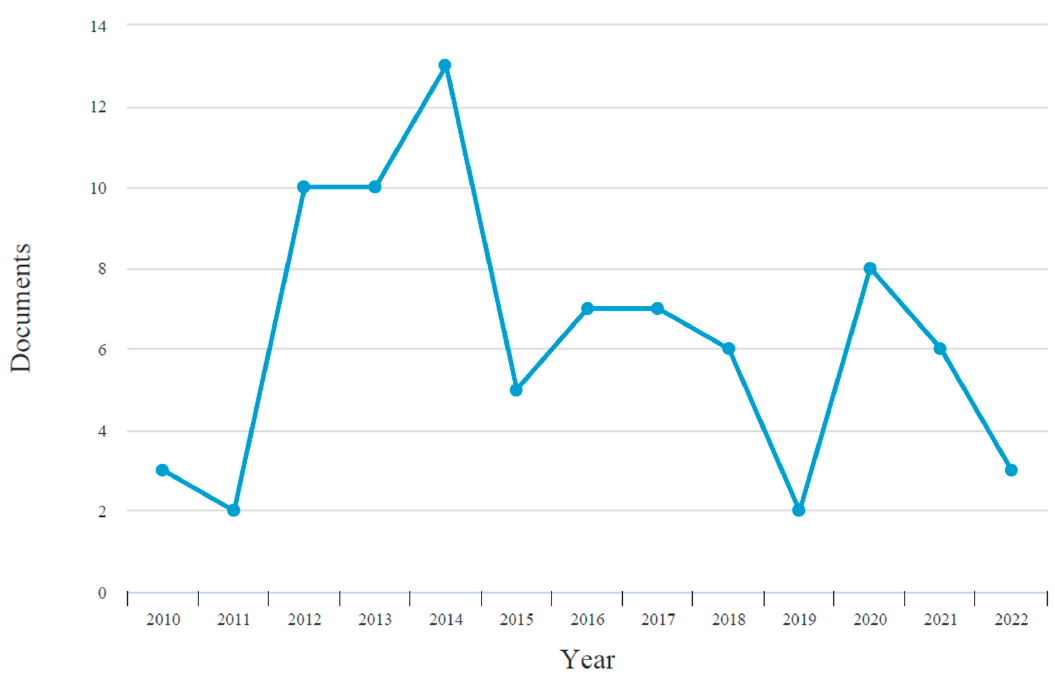
Figure 5. Self-initiated expatriation documents by year. Source: Data obtained from Scopus (August 2022).